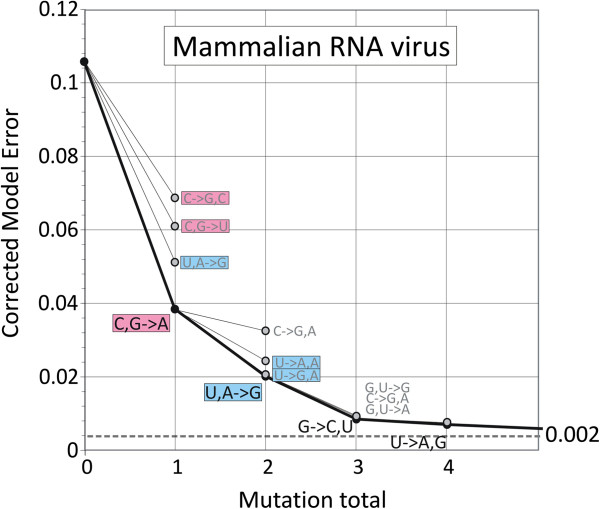
Baseline corrected model errors (y-axis) for mammalian RNA viruses using mutational models with 1 to 4 context-dependent mutational biases (labeled under graph line) and minimum values using up to 8 additional mutational biases (dotted line). Model errors for alternative mutational biases are shown as unfilled circles. Mutations that remove CpG and UpA are shown in pink and blue boxes respectively.